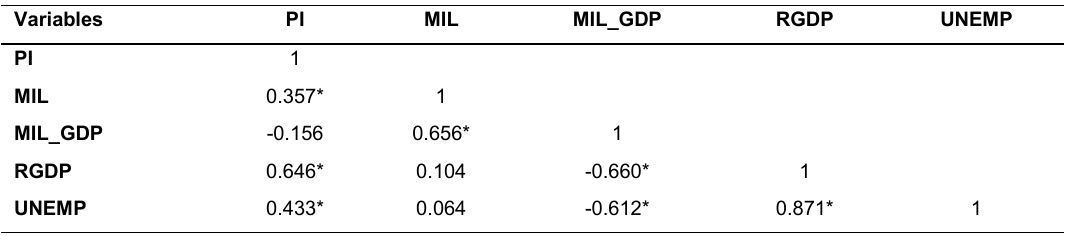
Table 3. Pairwise correlations.